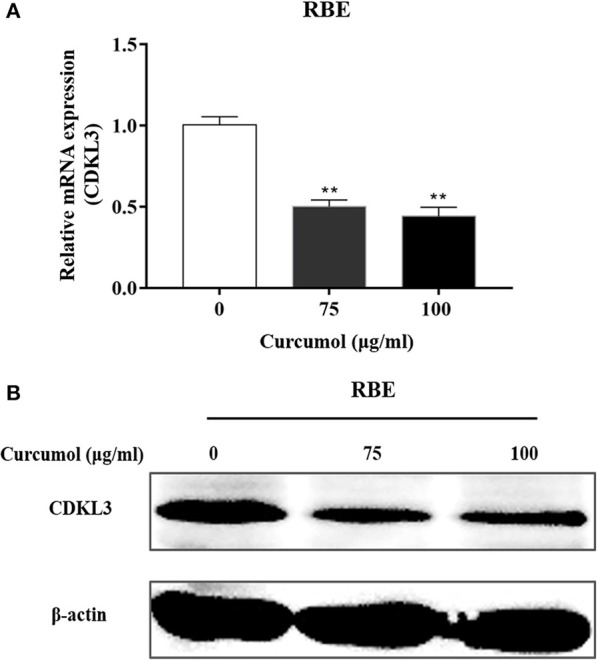
Effect of curcumol on the expression of CDKL3. Expression of CDKL3 in RBE cells treated with curcumol (75 and 100 μg/ml, 48 h) was detected by qRT-PCR (A) and Western blotting (B). The results shown are representative of three independent experiments. *P < 0.05, **P < 0.01, vs. control cells.